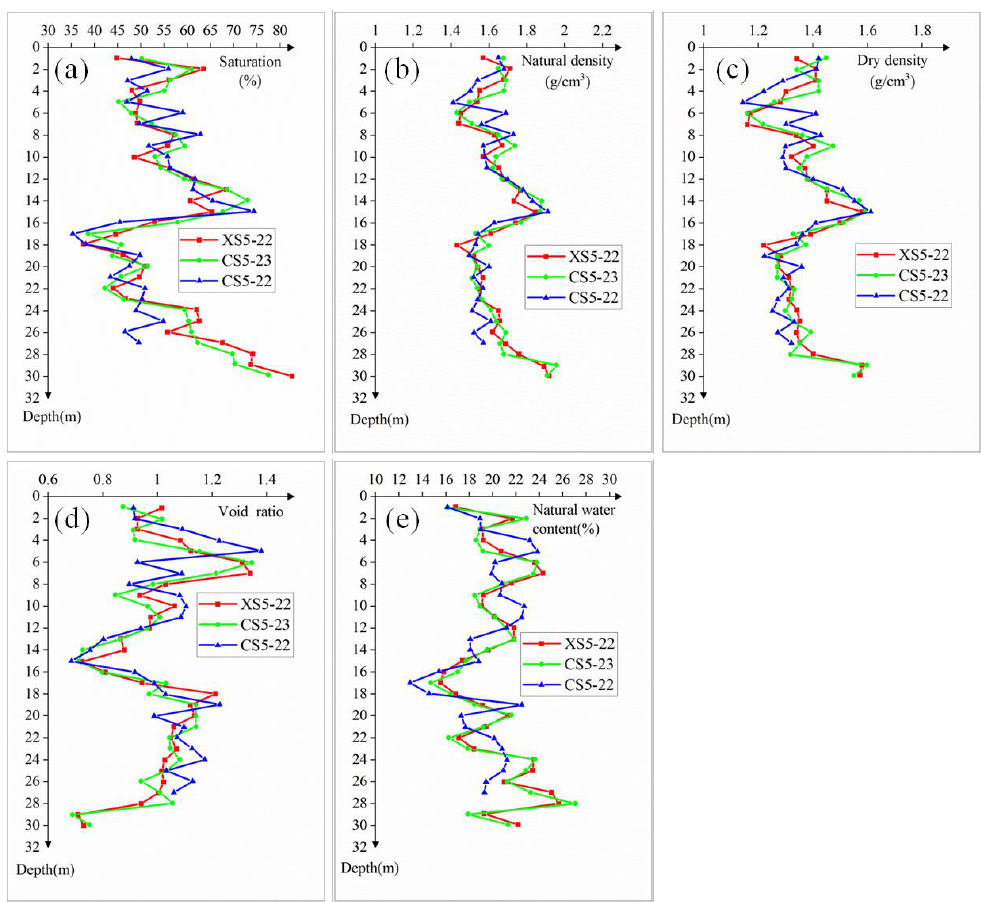
Figure 4. Loess sample parameters, ( a ) natural density, ( b ) dry density, ( c ) saturation, ( d ) void ratio, and ( e ) natural water content.